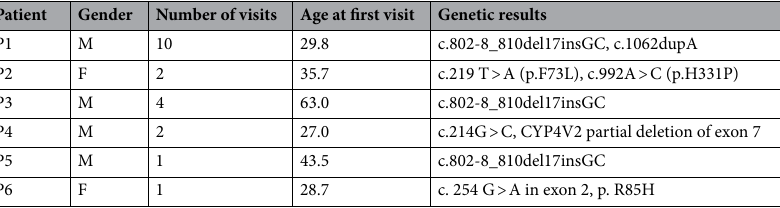
Table 1. Patient details (P1–P6). Four of the patients (P1, P2, P3, P4) had multiple visits and two patients (P5, P6) had a single visit examined in the study. The mean age of patients was 38 (sd = 12.5). Two of the patients were female and four of the patients were